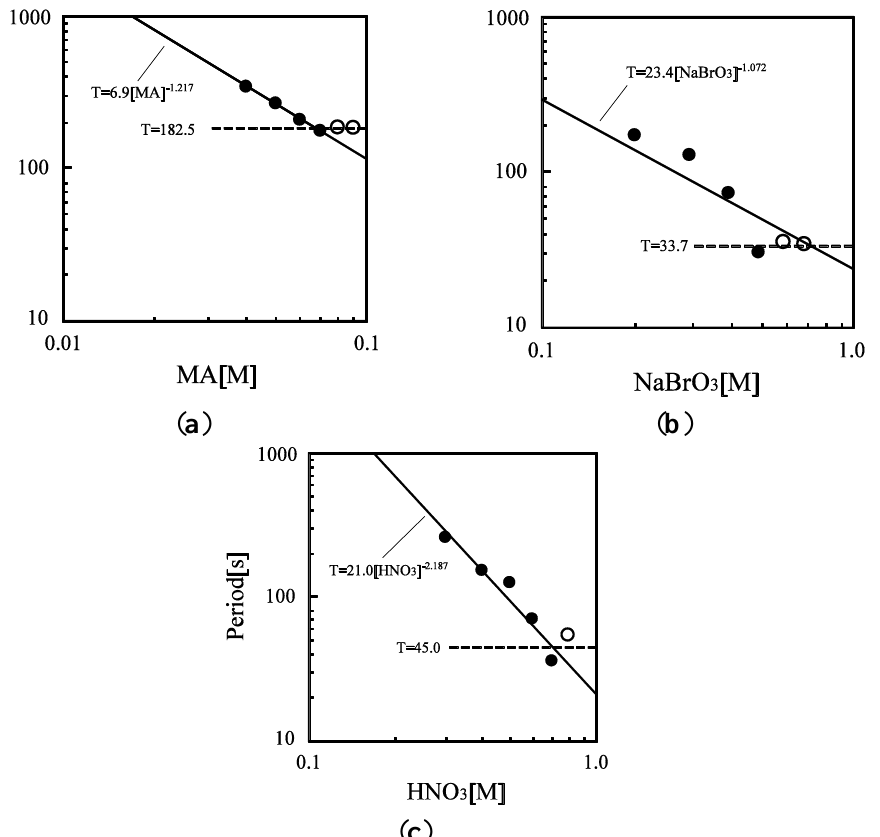
Figure 11. Logarithmic plots of period T (in s) vs. initial molar concentration of one BZ substrate at a constant temperature ( T = 20 °C) under fixed concentrations of the other two BZ substrates: ( a ) [NaBrO ] = 0.084 M and [HNO ] = 0.3 M; ( b ) [MA] = 0.0625 M and 3 3 [HNO ] = 0.3 M; ( c ) [MA] = 0.0625 M and [NaBrO ] = 0.084M. (●) and (○) plots show 3 3 the linear relation and the saturated line vs. initial concentration of one BZ substrate, respectively. (Reprinted from [45], Copyright American Chemical Society. Reproduced with